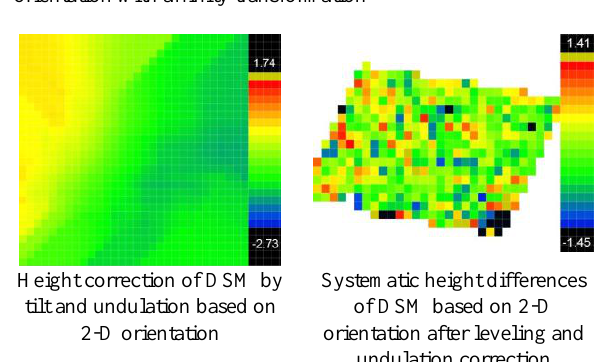
Figure 23. Analysis of Cartosat-1 DSM based on bias